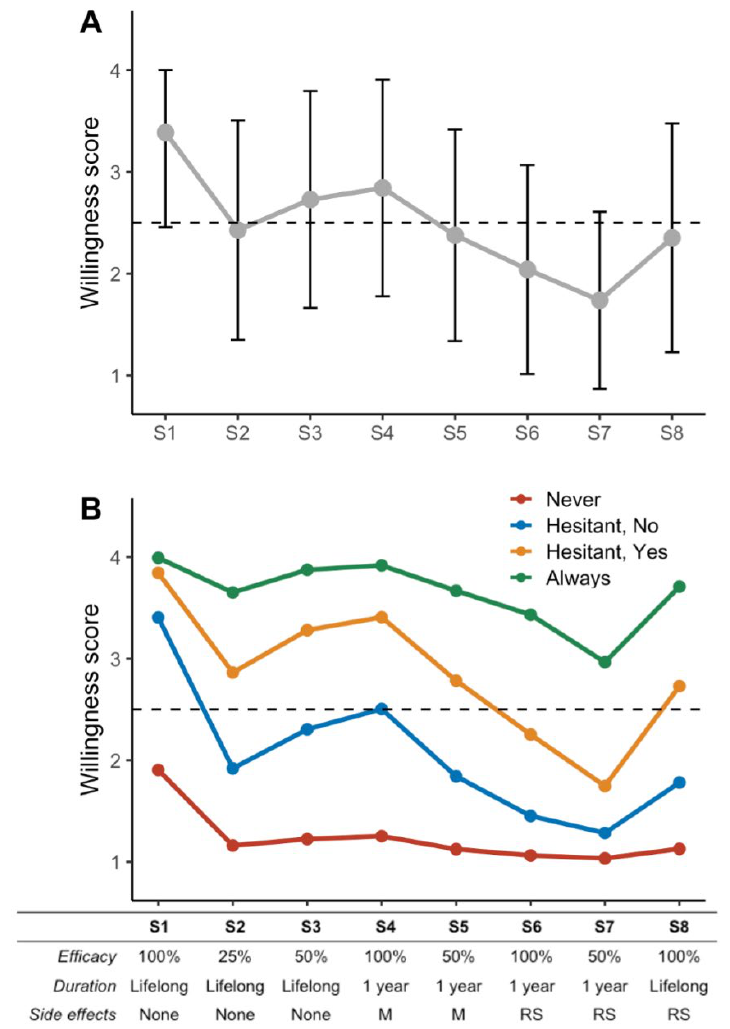
Figure 3. Trajectory of responses to vaccine scenarios and clustering. Eight vaccine candidate scenarios were submitted to participant in the same order from #1 (S1, ideal vaccine candidate conferring a lifelong immunity with 100% efficacy and no adverse events) to #8 (S8). Vaccine efficacy ranges from 25% to 100%. Immunization duration was 1-year to lifelong. Side effects were absent, moderate (M) or rare but severe (RS). Participant scored (1 to 4 scale) each scenario according to their willingness to be vaccinated with the proposed candidate from 1 (“Not at all”) to 4 (“Definitely”). ( A ) Average trajectory of responses across the scenarios; error bars represent standard-deviations, dashed horizontal line the limit between scores in favor (above) or in disfavor (below) of vaccine acceptance. ( B ) Average trajectories of vaccine acceptance for the four clusters obtained using a k-mean algorithm for longitudinal data (see methods): “Never” group in red, “Always” group in green, “Hesitating but willing” group in yellow and “Hesitating and not willing” group in blue.